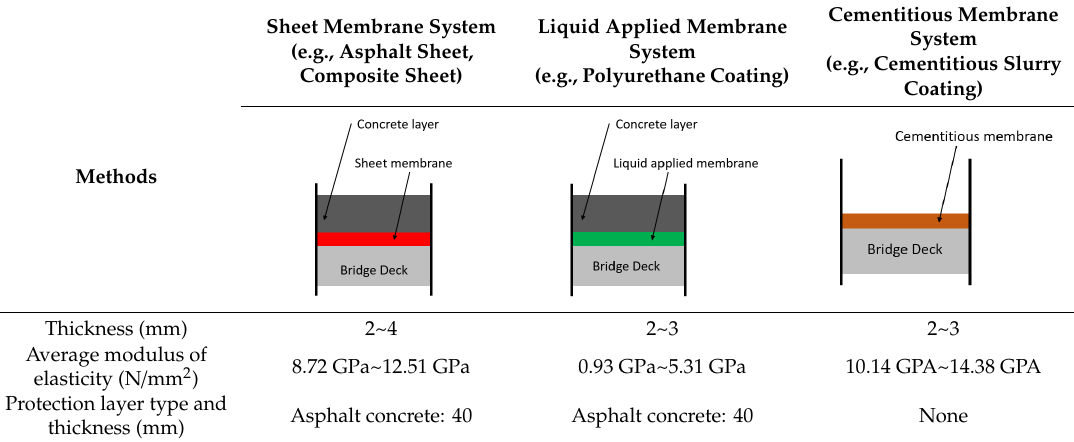
Table 2. Representative classification of waterproofing systems for railroad bridge deck in international application.